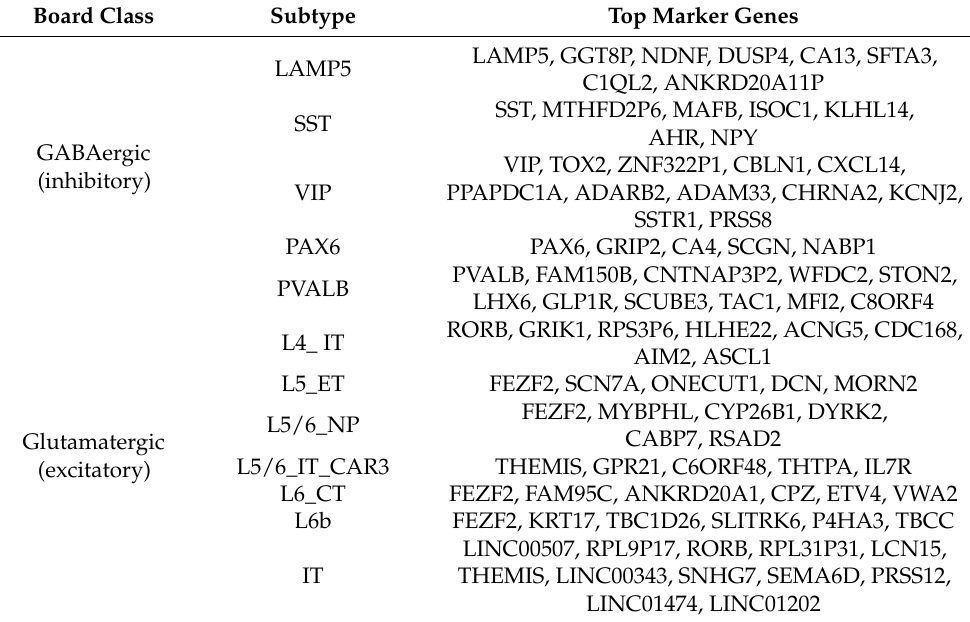
Figure 1. Distribution of brain cell types in bulk RNA-seq data. ( a ) Signature gene matrix of inferred 19 brain cell types by study. Heatmap showing a custom signature matrix created from scRNA-seq data with CIBERSORTx; ( b ) box plots depict distributions of 19 brain neuronal and non-neuronal cell types between SCZ and normal samples (depicted p -values are from the Wilcoxon test). ** p < 0.01; *** p < 0.001; **** p < 0.0001. OPC, oligodendrocyte precursor cell; VLMC, vascular leptomeningeal cell; IT, intratelencephalic; NP, near-projecting; CT, corticothalamic; ET, extratelencephalic–pyramidal tract. Table 1. Marker genes of each cell type in the signature matrix.